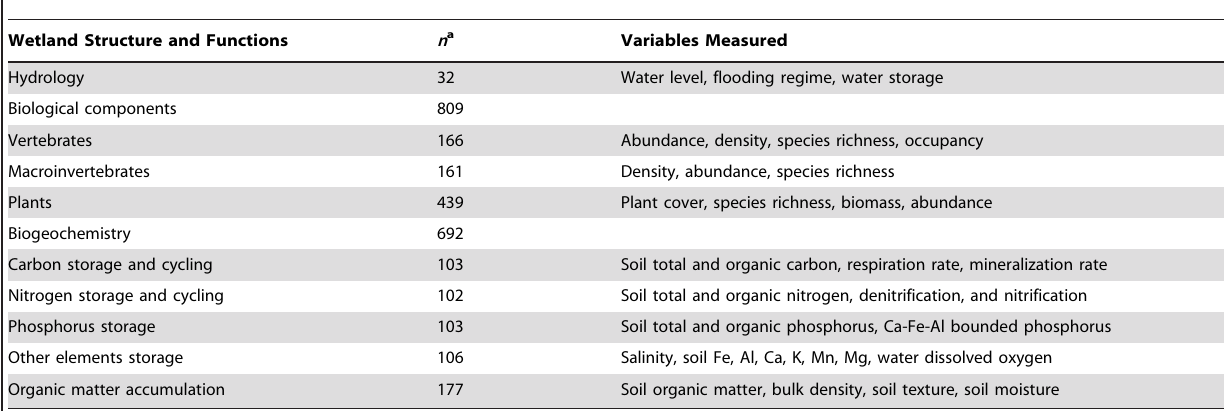
Table 1. Variables measured simultaneously in restored or created and reference wetlands to estimate wetland restoration performance over